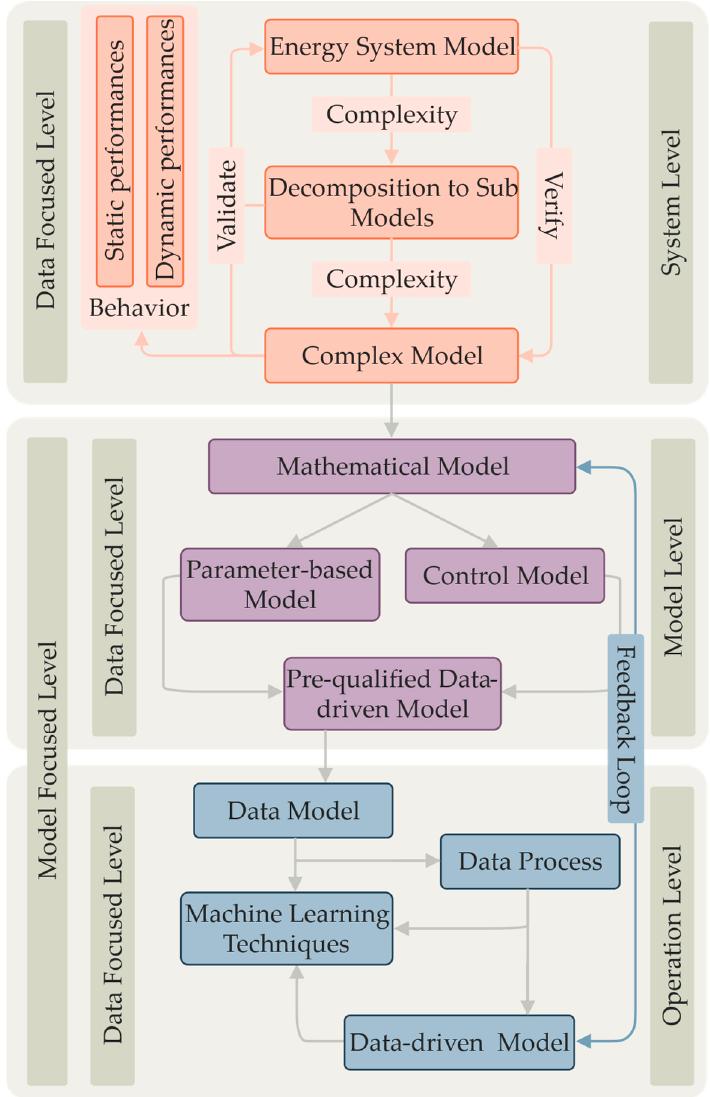
Figure 1. The thematic framework illustrates the systematic process of transferring the system parameter-based model to a data-driven based model.